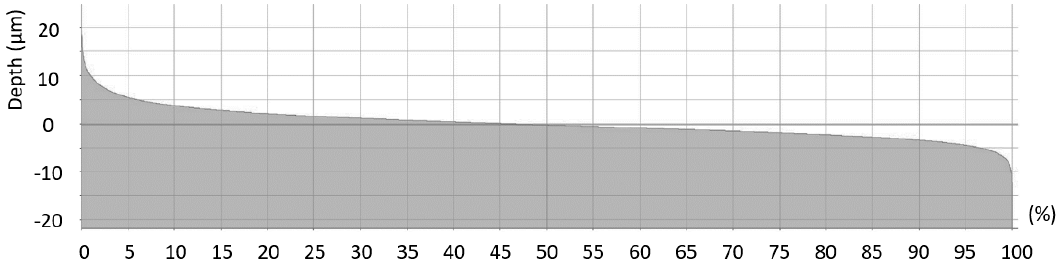
Figure 12. Example of Firestone–Abbott curve of the selected area ( f z = 0.05 mm and v c = 90 m.min − 1 ).